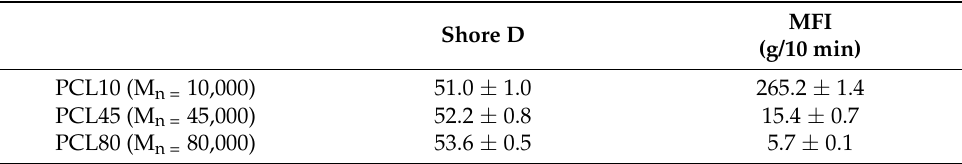
Table 1. Shore D and MFI values of PCL